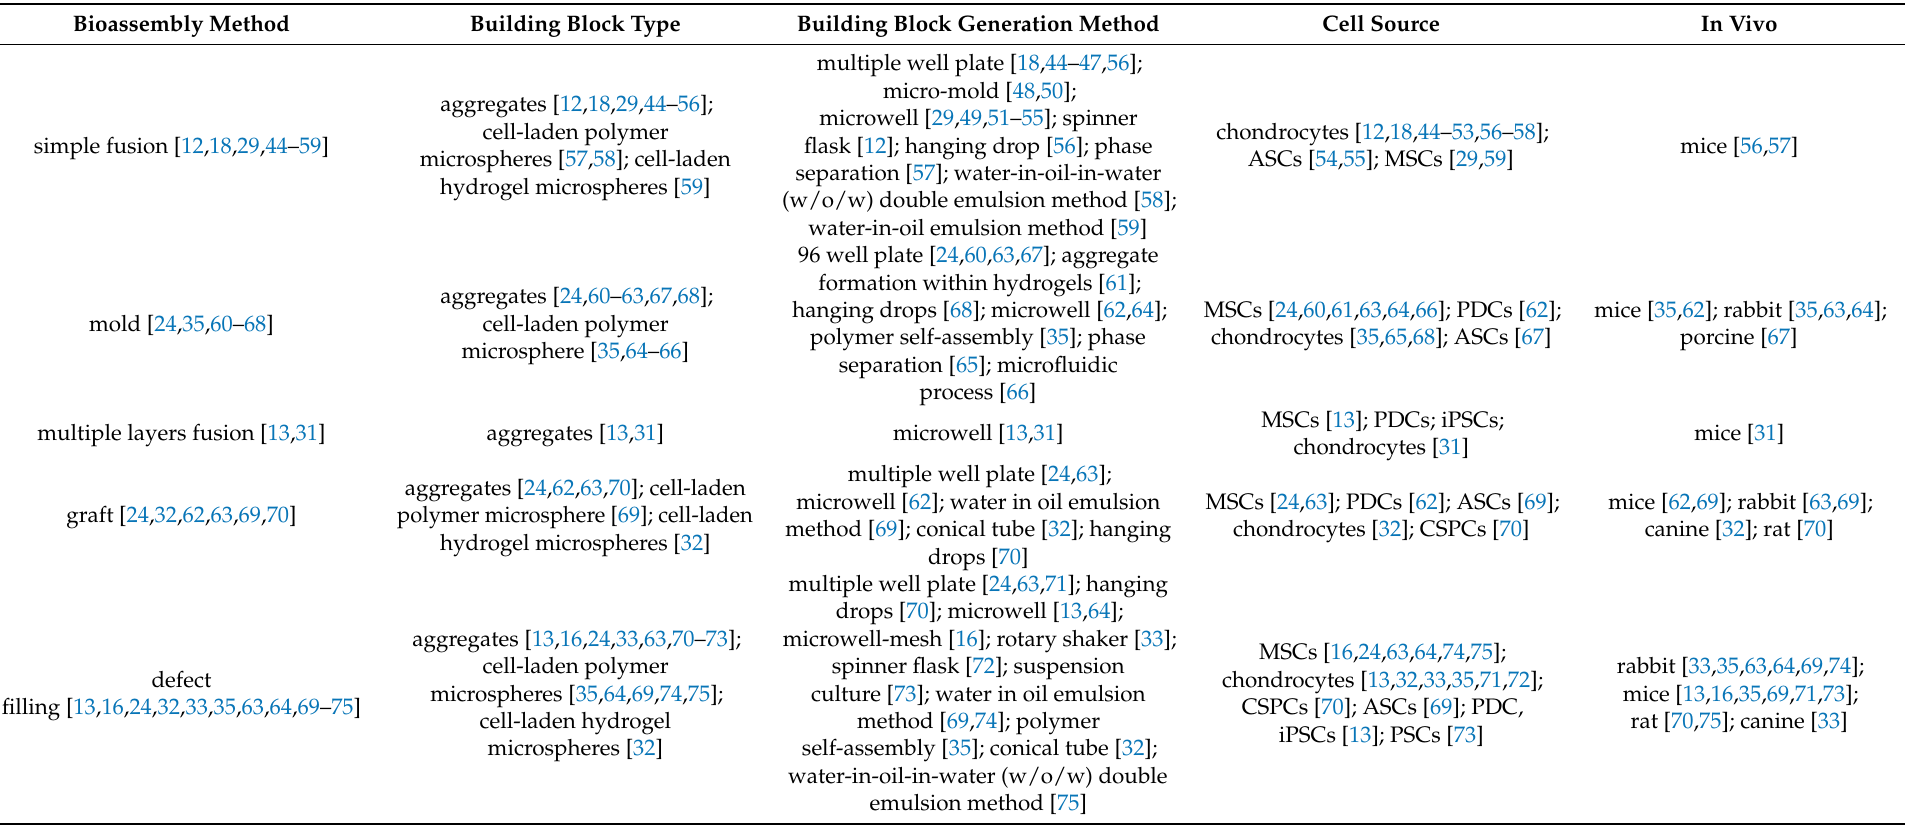
Table 1. Summary of the non-bioprinting bioassembly